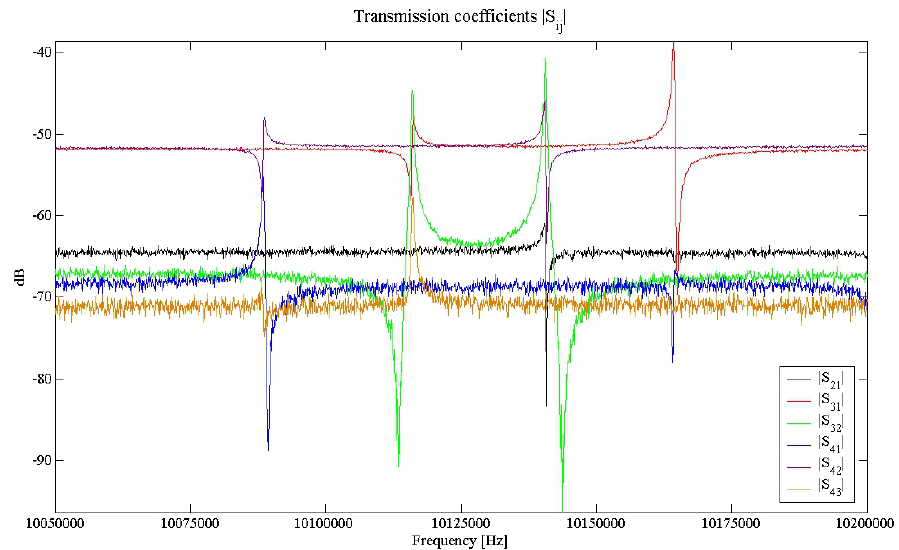
Figure 4. Moduli of the transmission parameters of the four ports network corresponding to the